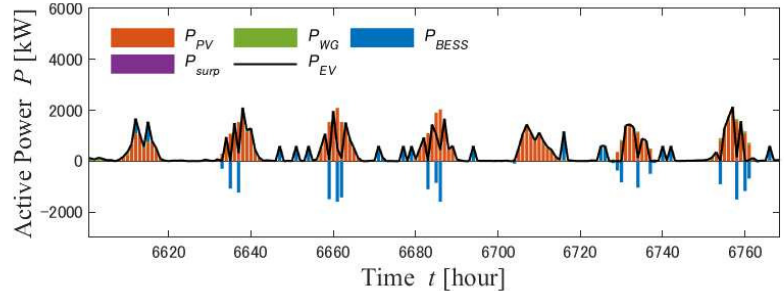
Figure 23. Generated power and load from October 1 to 7 (Case 2).